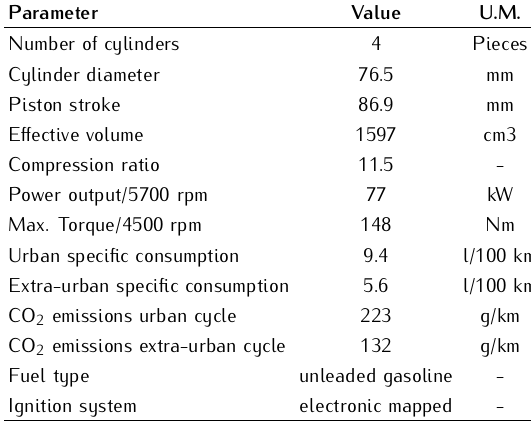
Table 1. Technical specifications of engine and vehicle used in experimental